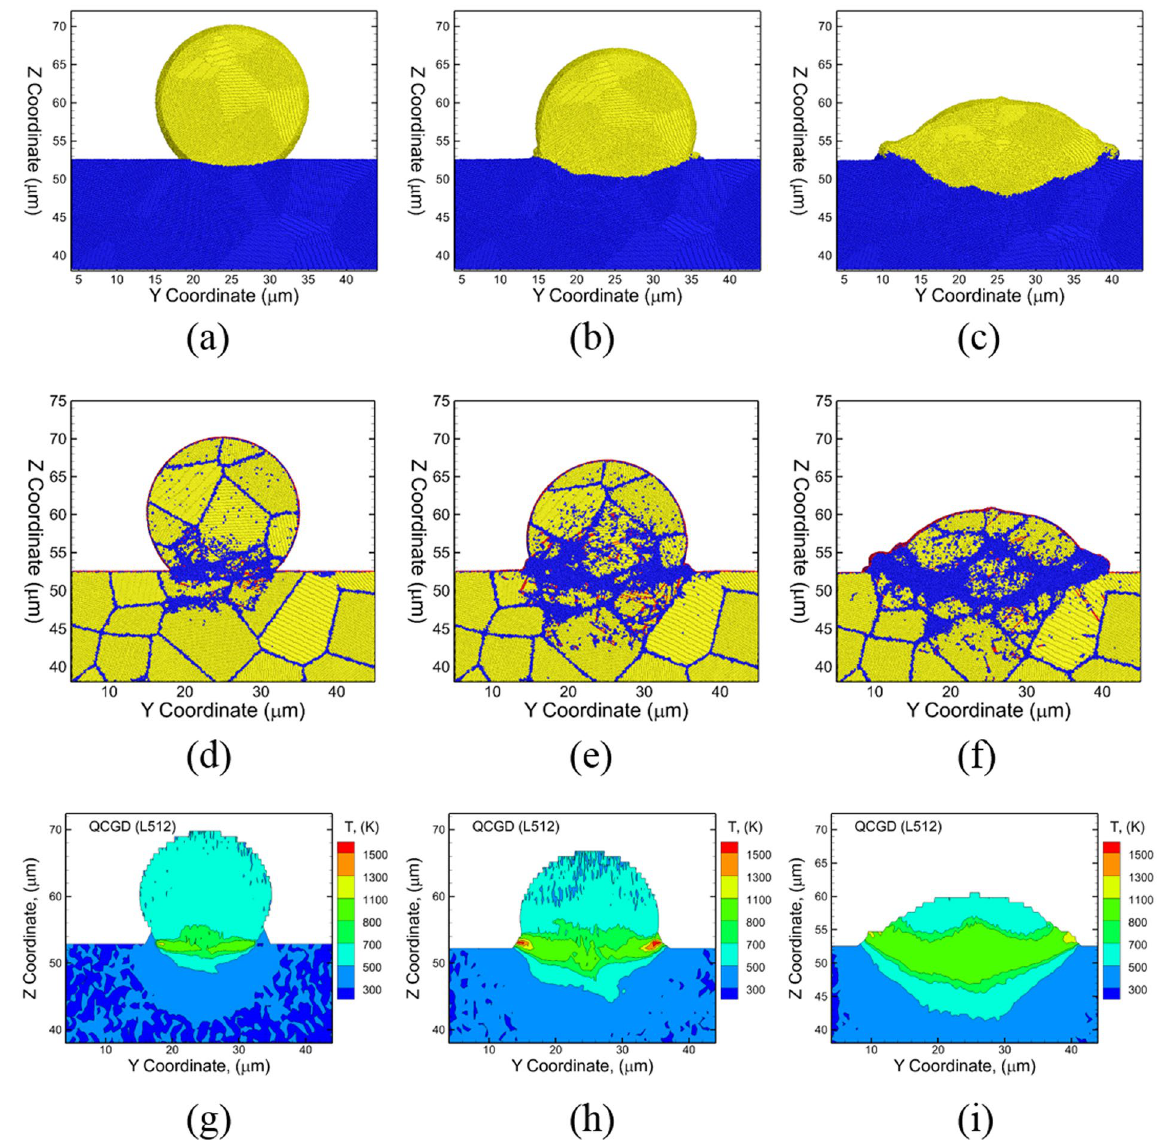
Figure 3. Snapshots showing the yellow R-atoms of the particle and blue R-atoms of the substrate during CS impact at a velocity of 1600 m/s at ( a ) t = 2 ns (just after impact), ( b ) t = 4 ns (visual evidence of “jetting”), and ( c ) t = 10 ns (maximum penetration depth reached). The corresponding plots showcasing the microstructural features are shown from ( d – f ). The atoms are colored based on common neighbor analysis and yellow atoms represent fcc stacking, red atoms represent hcp stacking, purple atoms represent a surface and blue atoms represent a disordered structure. The 2D plots showing the variations of temperatures at the times of ( d ) t = 2 ns showing the highest temperature zone generated at the center of the interface, ( e ) at t = 4 ns showing the shift of the peak temperatures to the periphery of the interface and corresponds to the onset of “jetting”, and ( f ) at t = 10 ns where heat transfer spreads high temperatures into the bulk of the particle due to continued deformation of the particle and the